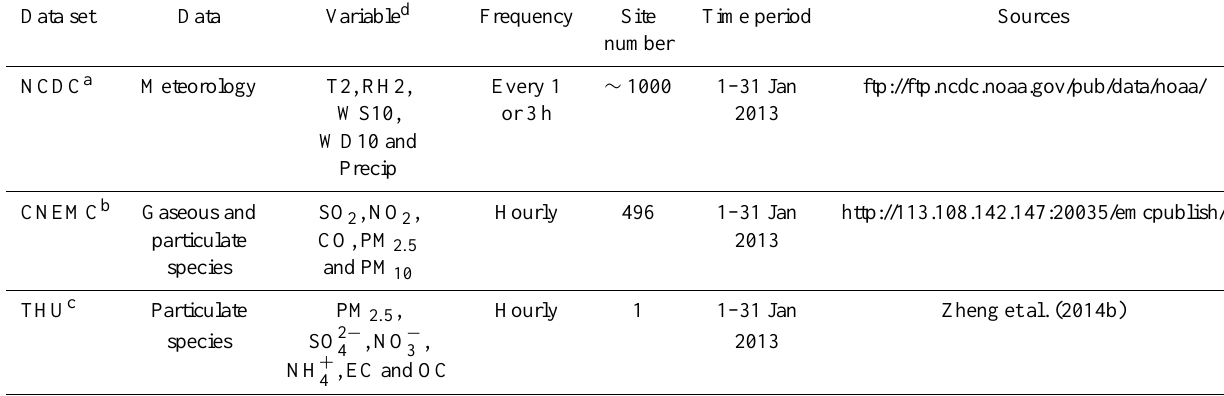
Table 5. Observational data for model evaluation.